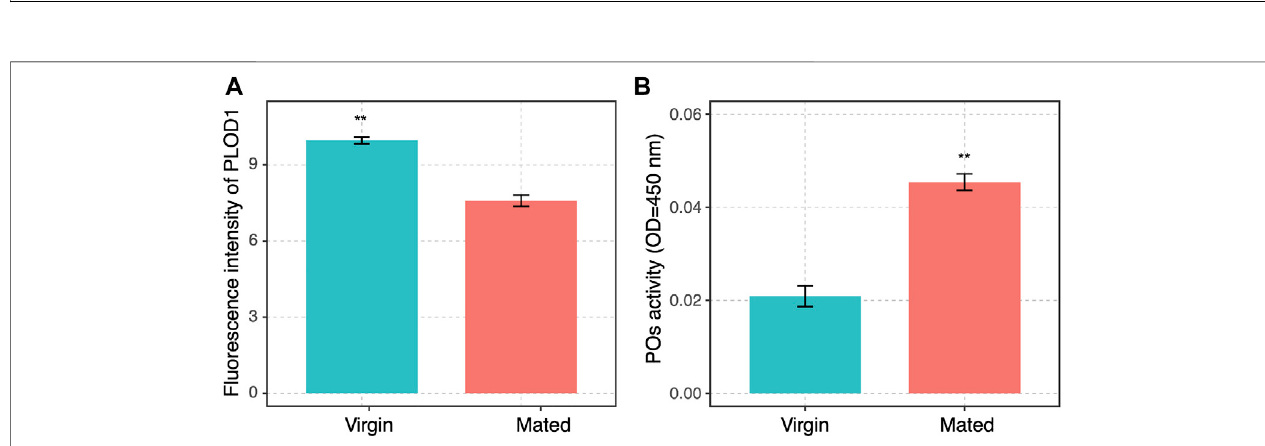
FIGURE 6 | (A) The PLOD1 fl uorescence intensity in spermathecae of mated and virgin queen was exhibited. The signi fi cant differences between the virgin (blue bars) and mated queens (red bars) are denoted with asterisks. ** p < 0.01. (B) POs activity in spermathecae of virgin and mated queens of bumblebee, at 24 h post mating. The activity of PO was signi fi cantly increased in the spermathecae of mated bumblebee queens. The signi fi cant differences between the control group (virgin queens,bluebars)andmatedqueens(redbars)aredenotedwithasterisks.** p < 0.01.Threeindependentbiologicalreplicateswereperformedforeachtreatment.